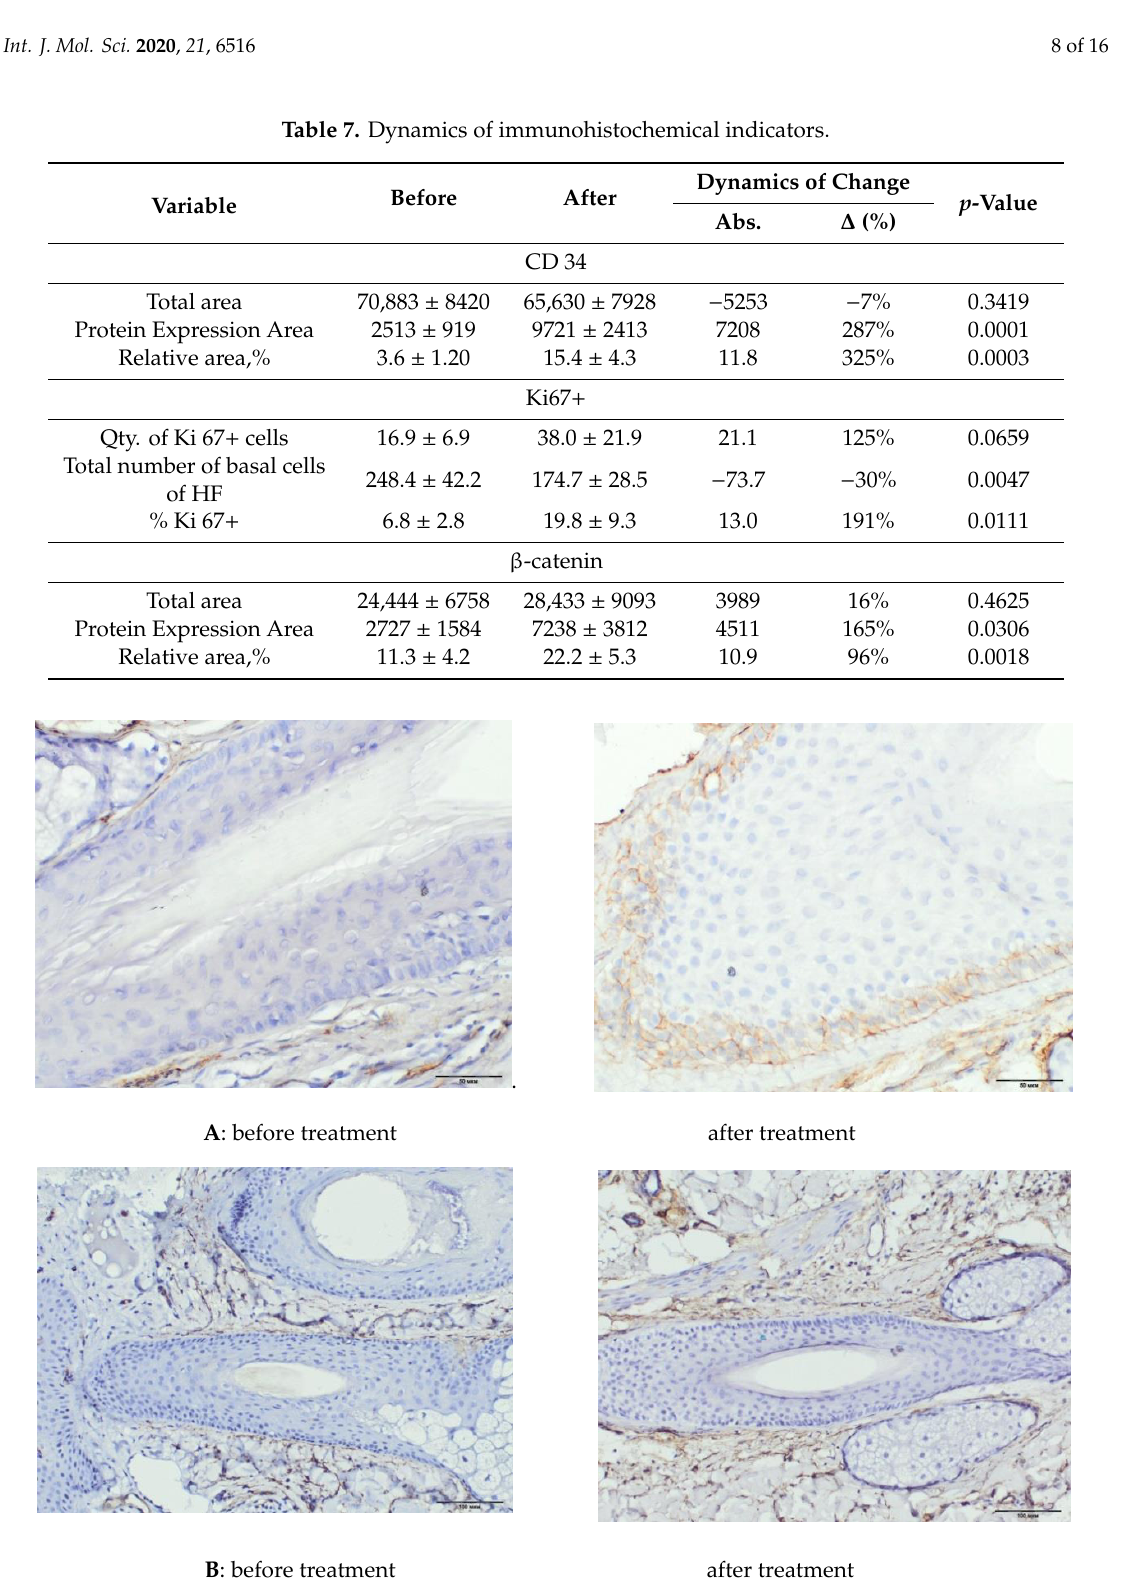
Figure 5. Area of CD 34. ( A ): Area of CD 34 + in the outer root sheaths of the HF, magnification × 400. ( B ) Area of CD 34+ in the interfollicular matrix, magnification ×200.